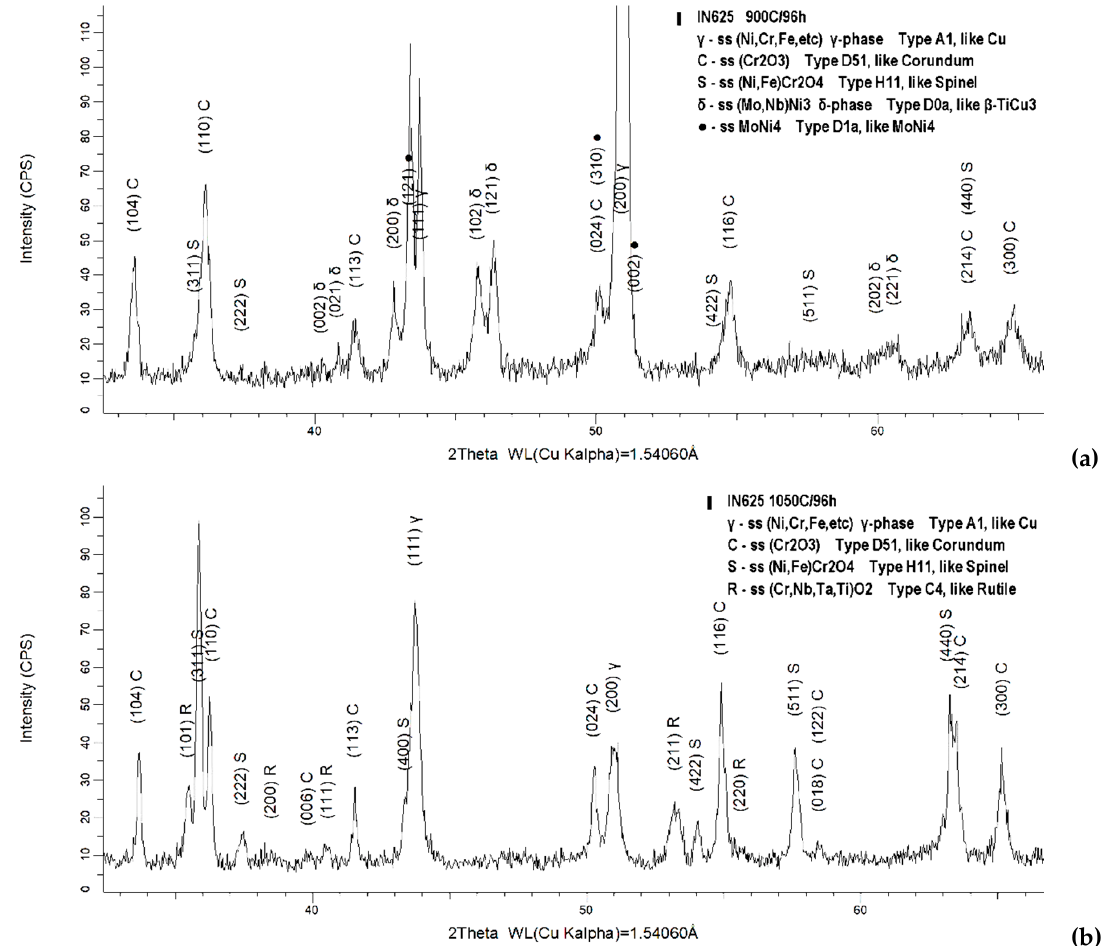
ff raction patterns of the specimens oxidized for 96 h at 900 ◦ C ( a ) and 1050 ◦ C ( b Figure 7. Diffraction patterns of the specimens oxidized for 96 h at 900 °C ( a ) and 1050 °C ( b ). Figure 7. Di